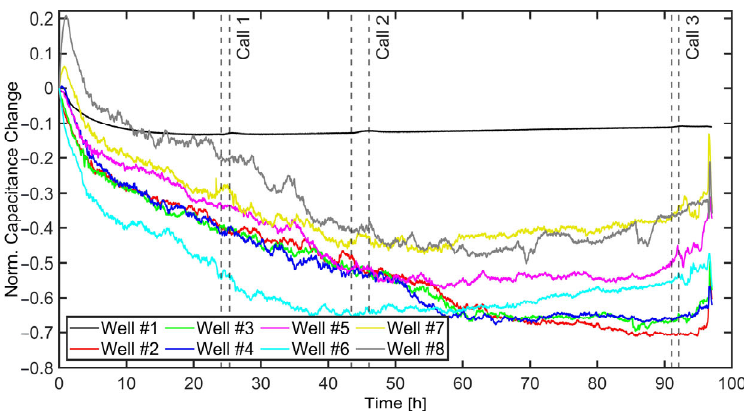
Figure 10. Results of normalized resistance measurements for the signal with f = 4 kHz, measured during 93 h of cell culture.